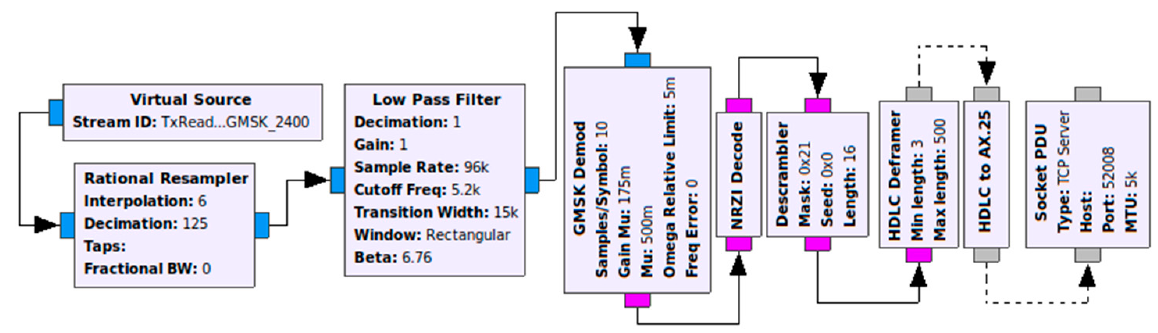
Figure 9. GMSK receiver design in GNU Radio.